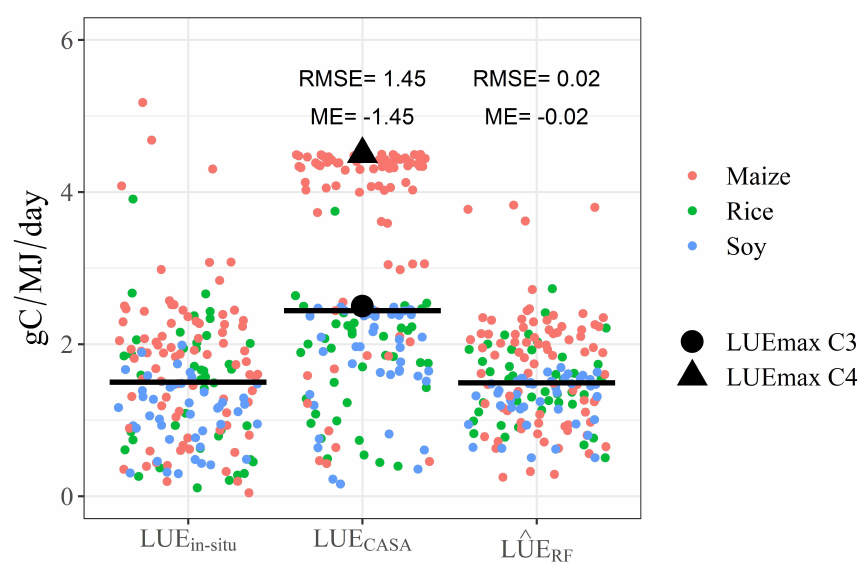
Figure 4. In situ light use efficiency (LUE in situ ) values compared with LUE reduced below its potential by stress scalars as per Equation (2) (LUE CASA ) and LUE predicted from a random forest model with satellite-derived and agroclimatic predictors ( ˆ LUE RF ) in Table 3. Median is shown with a horizontal line, and the fixed maximum light use efficiency (LUE max ) for C3 and C4 crops are shown with points.